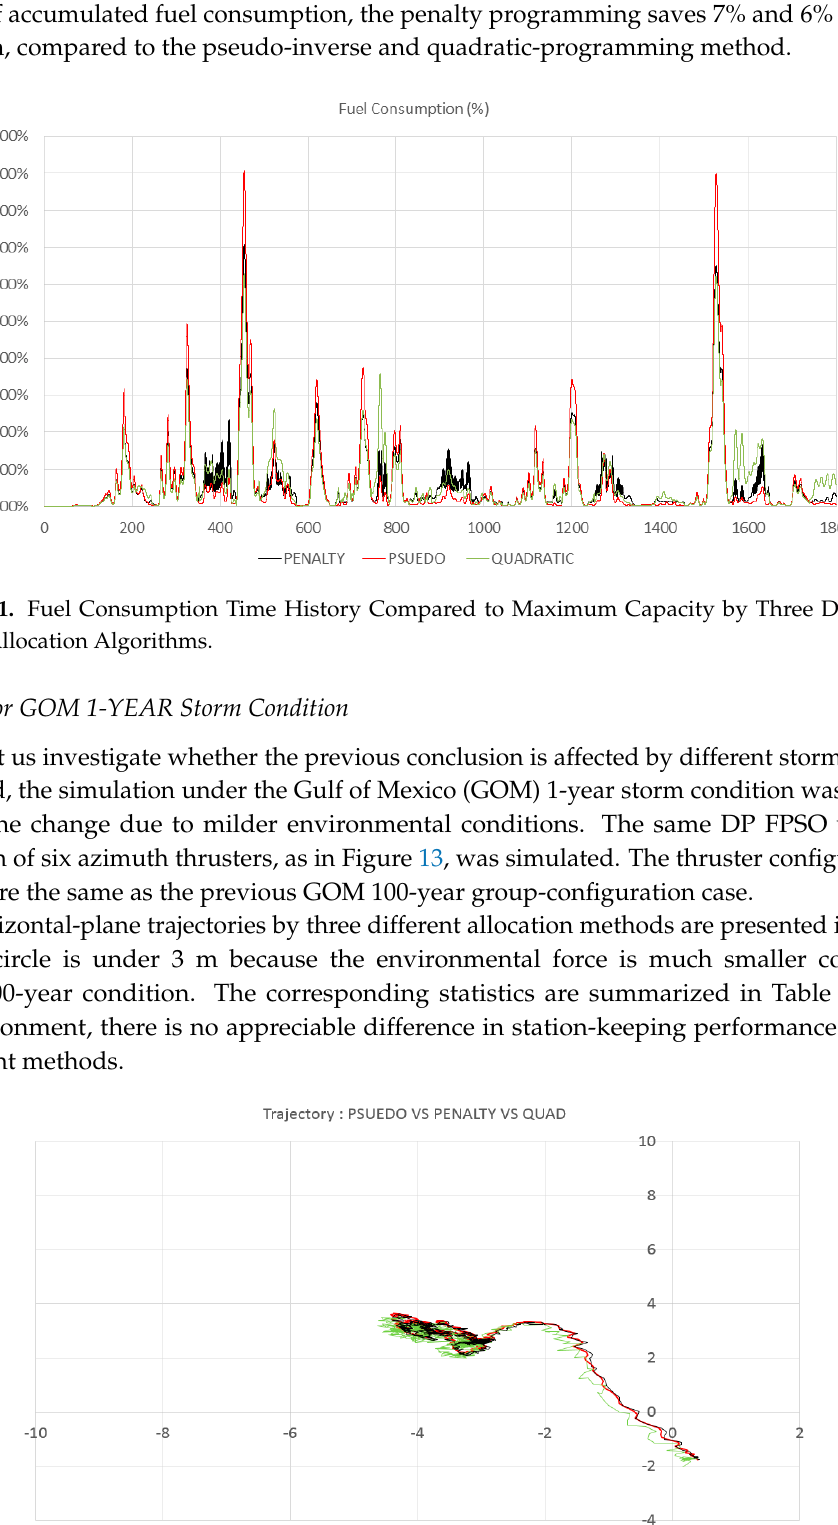
Figure 22 . Surge and Sway Trajectories by Three Different Thrust-Allocation Algorithms.